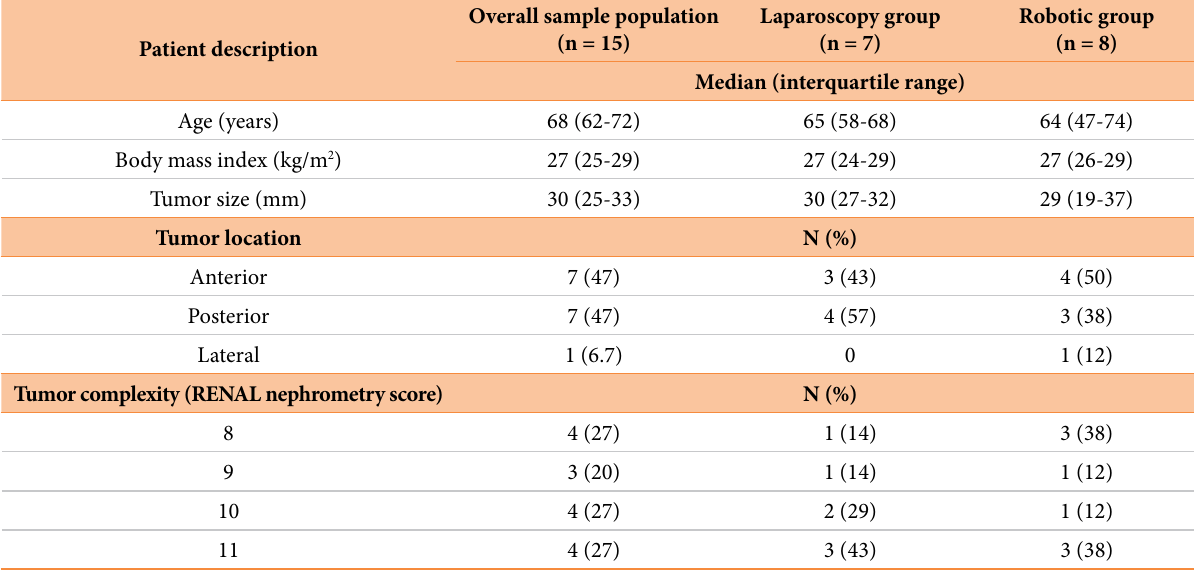
Table 1 - Descriptive characteristics of 15 patients with endophytic tumors who underwent partial nephrectomy guided by endocavitary ultrasound